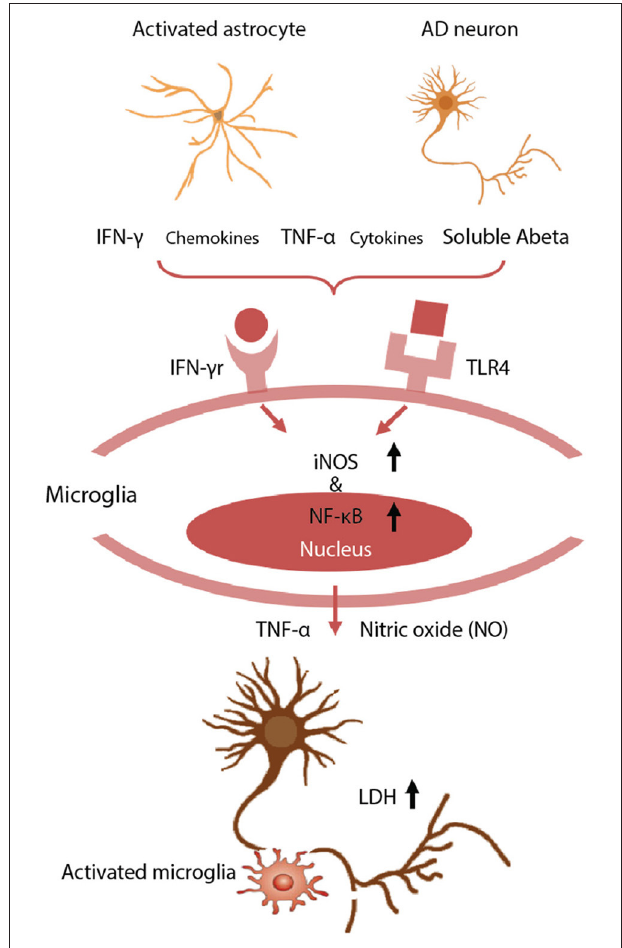
FIGURE 3 | Neurotoxic glia interactions mediated by TLR4 and IFN- γ receptor. Schematic of detrimental astrocyte-microglia activation in a 3D human AD model. The combination of A β derived from AD neurons and inflammatory cytokines from reactive astrocytes are detected by microglia via TLR4 and IFN- γ receptors. Then, the microglia subsequently activate the expression of iNOS and NF- κ B, and release TNF- α and cytotoxic NO, leading to neurodegeneration. Neuronal damage was assessed using a LDH assay to quantify membrane damage. Reproduced/adapted from reference [(89) ]